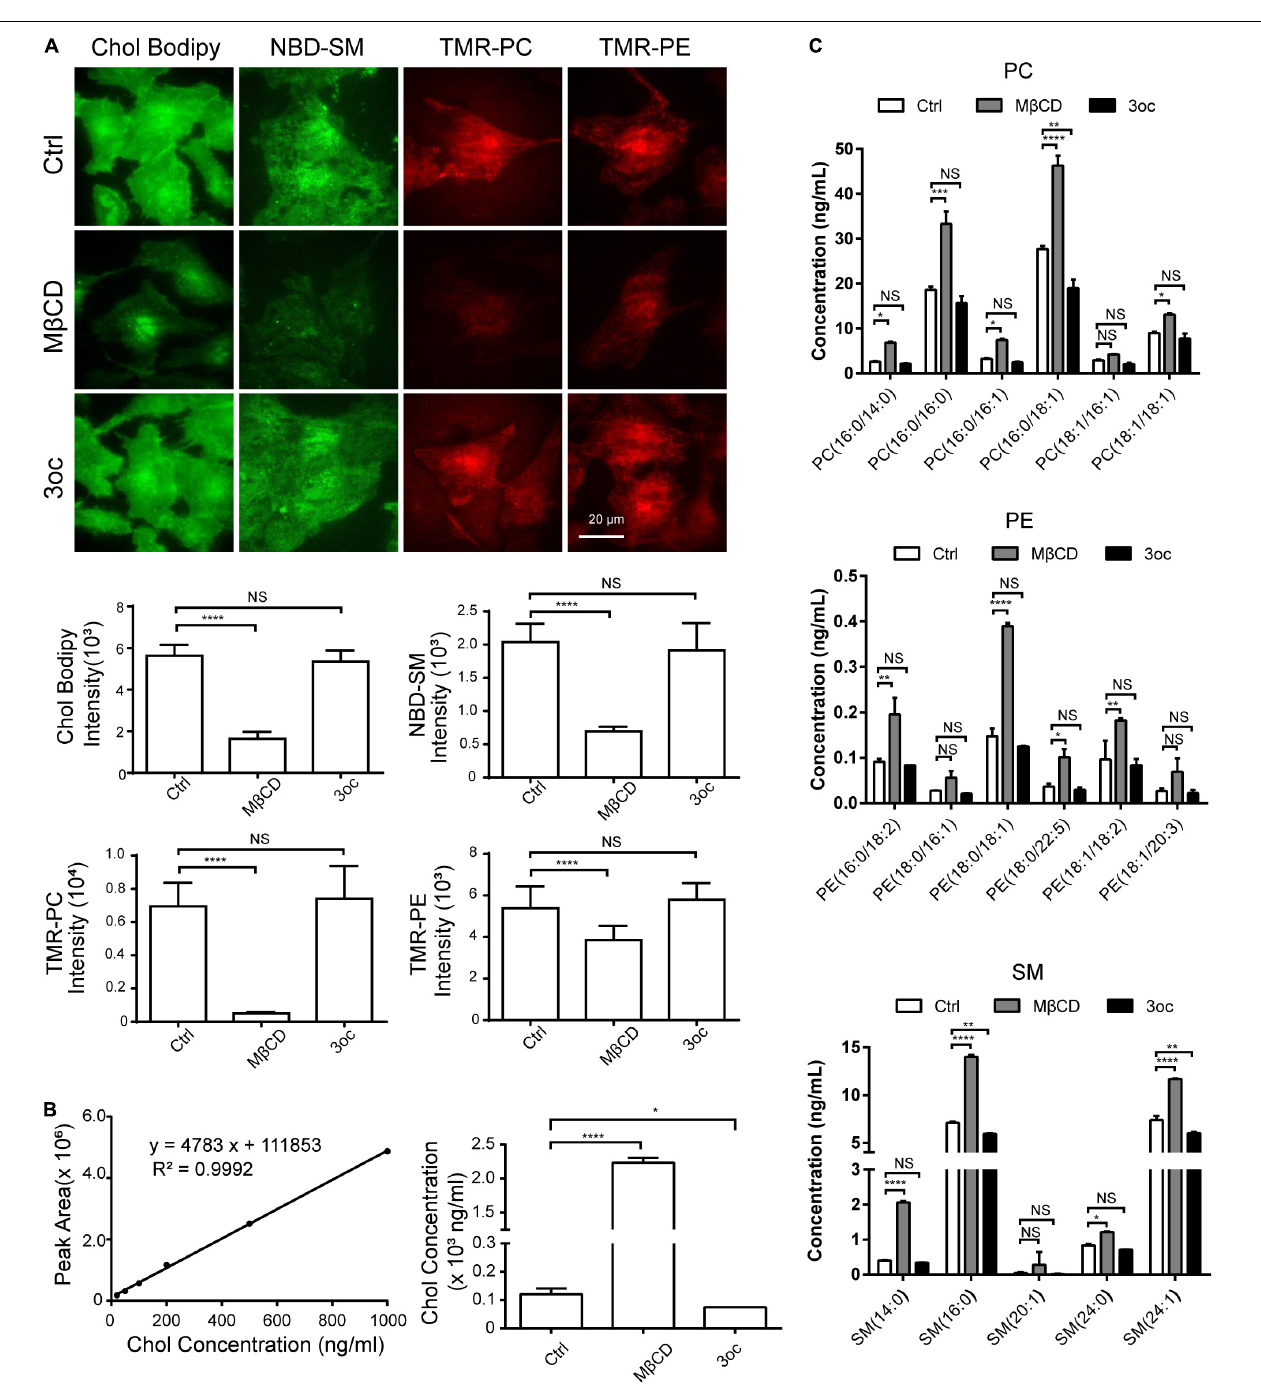
FIGURE 2 | Effects of M β CD and 3oc treatments on cell membrane components. (A) Fluorescently labeled cholesterol (Chol), sphingomyelin (SM), phosphatidylcholine (PC), and phosphatidylethanolamine (PE) are used to analyze the effects of total internal reflection fluorescence microscope (TIRFM) imaging. From left to right, BODIPY-Chol, NBD-SM, TMR-PC, and TMR-PE are used to label the Hela cell membrane. The histograms below are the average fluorescence intensity of about 30 cells in each group. Significant differences were analyzed by an unpaired t -test. (B) The concentrations of endogenous cholesterol in cell supernatant after M β CD and 3oc treatments were analyzed by liquid chromatography-mass spectrometry (LC-MS), the left panel is the cholesterol standard curve, and the right panel is the calculated results. (C) The concentrations of endogenous PC, PE, and SM in cell supernatant after M β CD and 3oc treatments were analyzed by LC-MS, from top to bottom are the concentration changes of PC, PE, and SM. Significant differences were analyzed by a two-way ANOVA test. Scale bar = 20 µ m. Henceforth, *, **, ***, and ****, P < 0.05, 0.01, 0.001, and 0.0001, respectively.